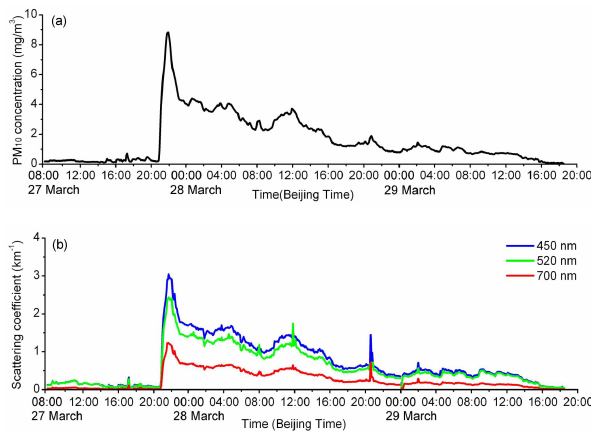
Fig. 9. Temporal evolutions of (a) PM 10 concentration and (b) aerosol scattering coefficient from 08:00 (Beijing Time), 27 March to 18:30, 29 March 2007. The dust aerosol scattering coefficient and PM 10 concentration had similar variation trends with the maximums at 22:00, 27 March.